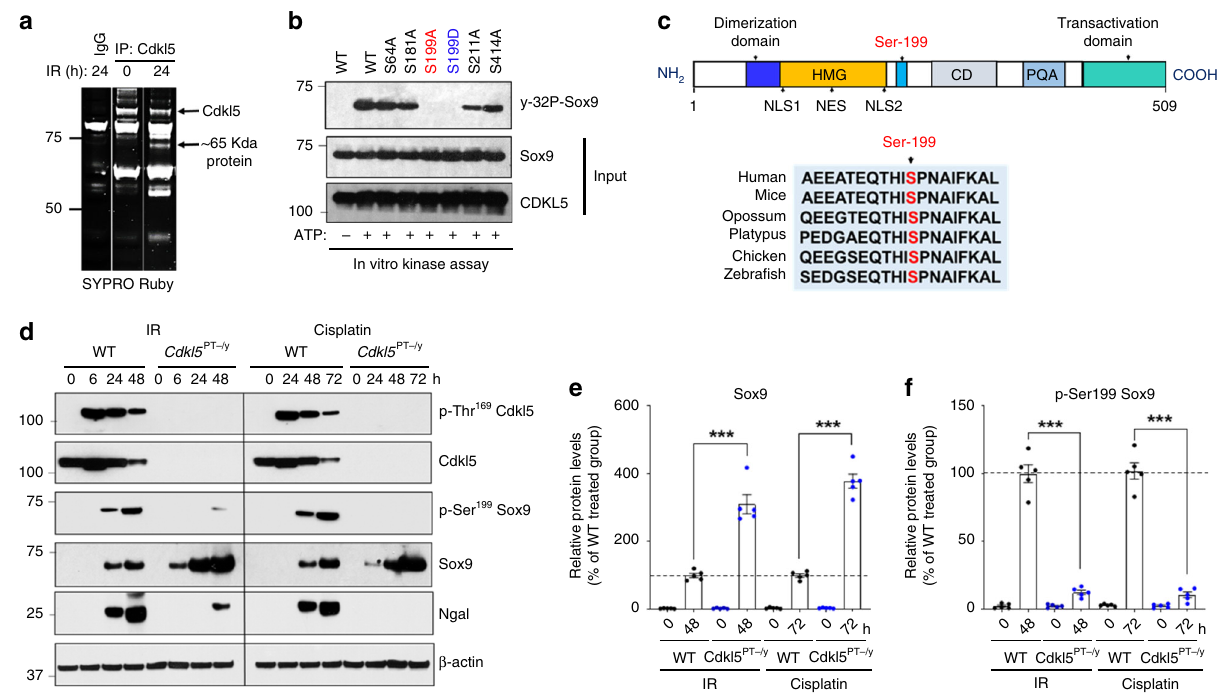
Fig. 4 Cdkl5 phosphorylates Sox9 at Serine 199 site. a Bilateral renal ischemia was induced in C57BL/6 mice for 30 min followed by reperfusion for 1 day. Renal cortical lysates were then used to immunoprecipitate Cdkl5, while IgG was used as negative control. Immunoprecipitates were then run on a 4 – 12% gradient SDS-PAGE gel followed by protein visualization with SYPRO Ruby Protein Gel Stain. The ~65-kDa Cdkl5-interacting protein was then identi fi ed by mass spectrometric analysis as Sox9 as described in the “ Methods ” section. b Puri fi ed wild-type Cdkl5 and wild-type and mutant Sox9 proteins were co- incubated in a kinase assay buffer with [gamma-32P]-ATP for 30 min. Samples were then run on SDS-PAGE gel followed by transfer to PVDF membrane. Radiolabeled Sox9 was examined by autoradiography, followed by western blot analysis to examine the input proteins. Blots are representative of two independent experiments. c Schematic representation of Sox9 protein (modi fi ed from ref. 64 ). Protein sequence analysis showed that the sequence surrounding the Ser-199 site is highly conserved. HMG indicates high-mobility group box DNA-binding domain, CD indicates conserved domain, and PQA indicates proline – glutamine – alanine-rich domain. d Control, cisplatin, and ischemic renal tissues from control and Cdkl5 PT − /y mice were subjected to immunoblot analysis of indicated proteins. Blots are representative of at least three independent experiments. e , f Densitometric analysis of Sox9 and p- Ser-199 – Sox9 protein levels. The graph represents cumulative results ( n = 5 independent biological samples) from three independent experiments. Densitometric analysis was carried out using Image J, and the signals of indicated proteins were normalized by actin levels in the same samples. In all the bar graphs, experimental values are presented as mean ± s.e.m. The height of error bar = 1 s.e., and p < 0.05 was indicated as statistically signi fi cant. One- way ANOVA followed by Tukey ’ s multiple-comparison test was carried out, and statistical signi fi cance is indicated by * p < 0.05, ** p < 0.01, *** p < 0.001. Source data are provided as a Source Data fi